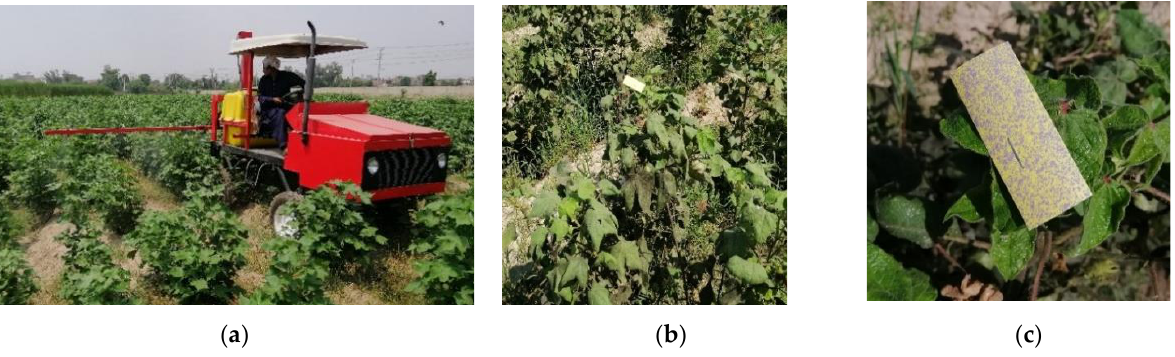
Figure 2. Field trials: ( a ) Sprayer in the cotton field during trials, ( b ) water-sensitive paper placement at the top of the plant canopy, ( c ) water-sensitive paper after spraying.